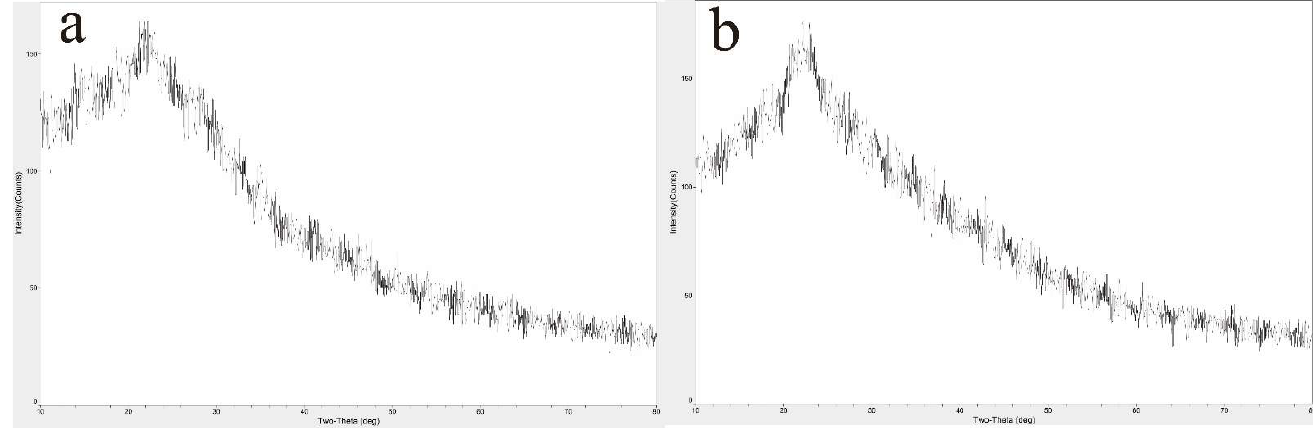
Figure 3. X-ray diffraction (XRD) of HPIDF/F-HPIDF. ( a : HPIDF; b : F-HPIDF).